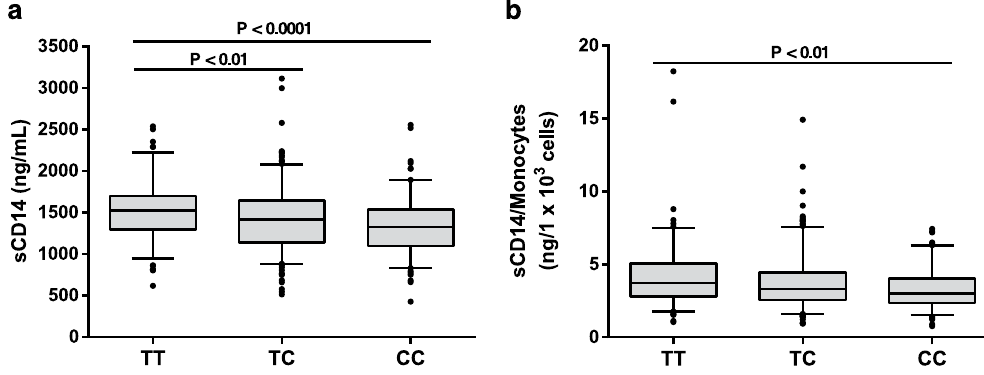
Figure 3. Impact of the CD14 ( − 159 C/T) SNP (rs2569190) on sCD14 levels in serum. Absolute (ng/mL) ( a ) and relative (ng/1 × 10 3 monocytes) ( b ) sCD14 levels in serum samples from TT, TC and CC donors (healthy and asthmatics). * Kruskal-Wallis One Way Analysis of Variance on Ranks, P < 0.001; Dunn’s Method was used for multiple comparisons (numbers on the graph represent P